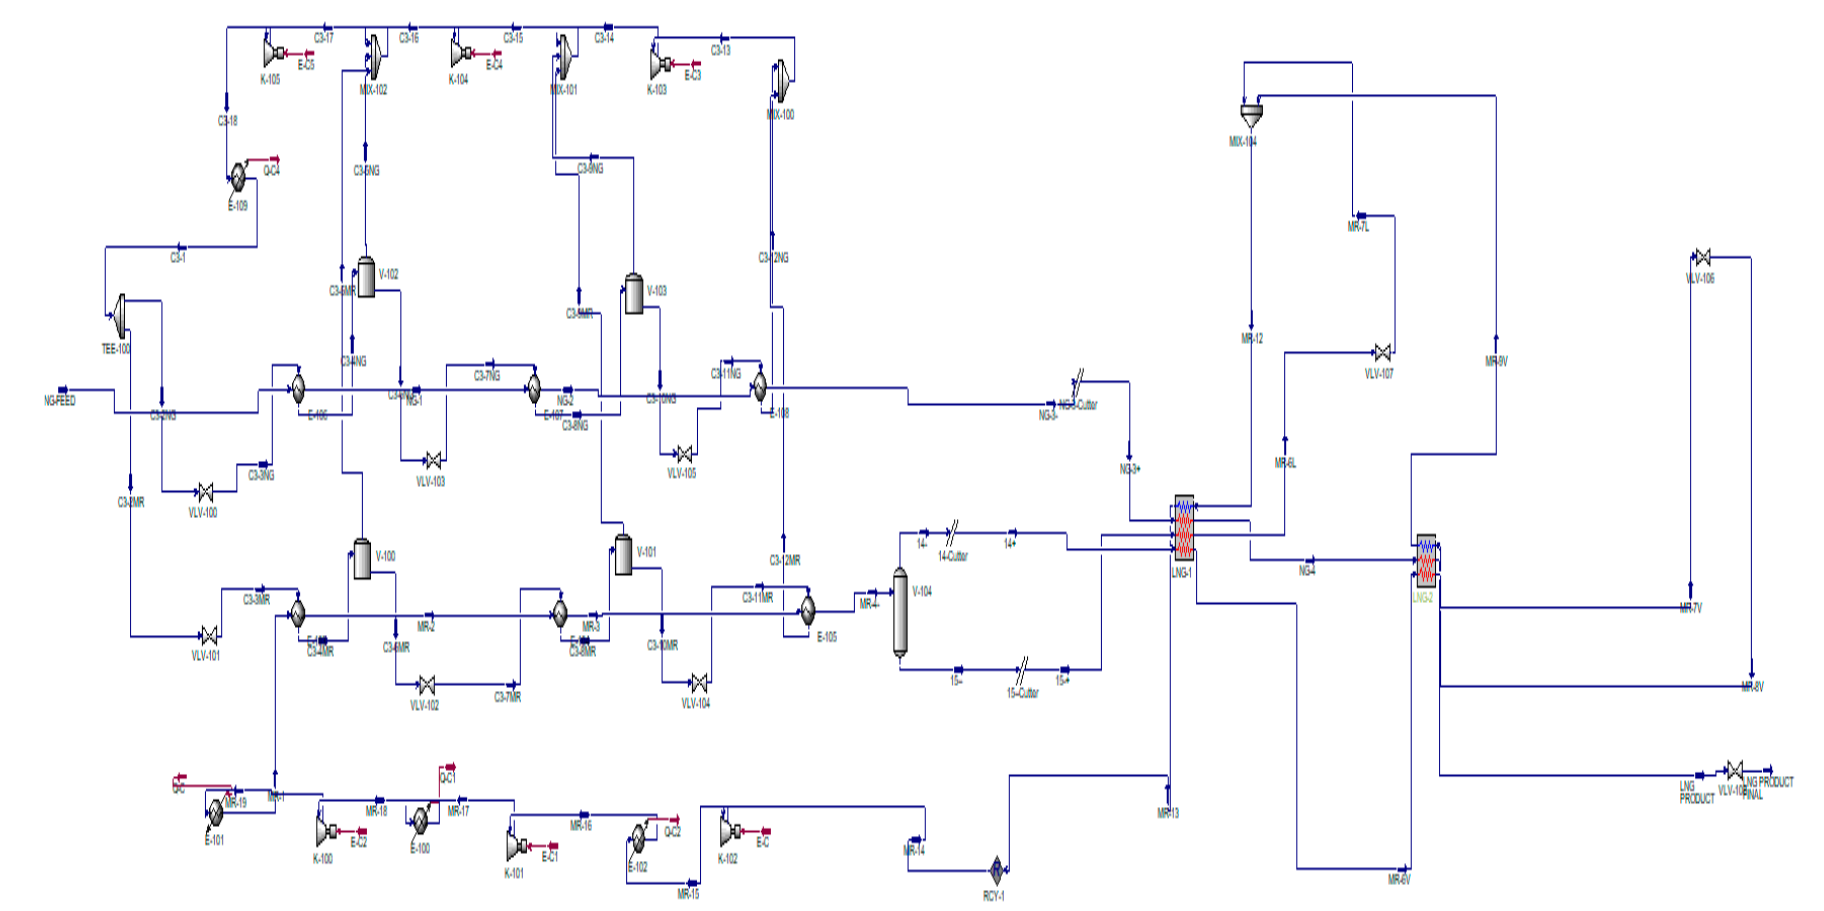
Figure 4. ASPEN HYSYS process flow diagram of the C3MR process.